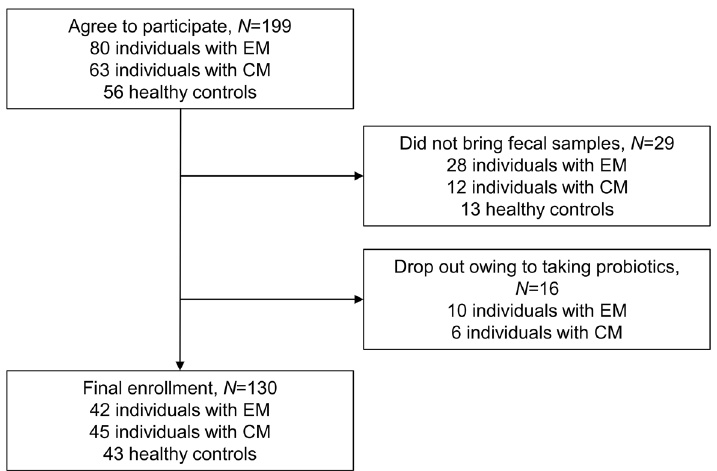
Figure 1. Flow of participants in a study on the composition of gut microbiota in participants with episodic or chronic